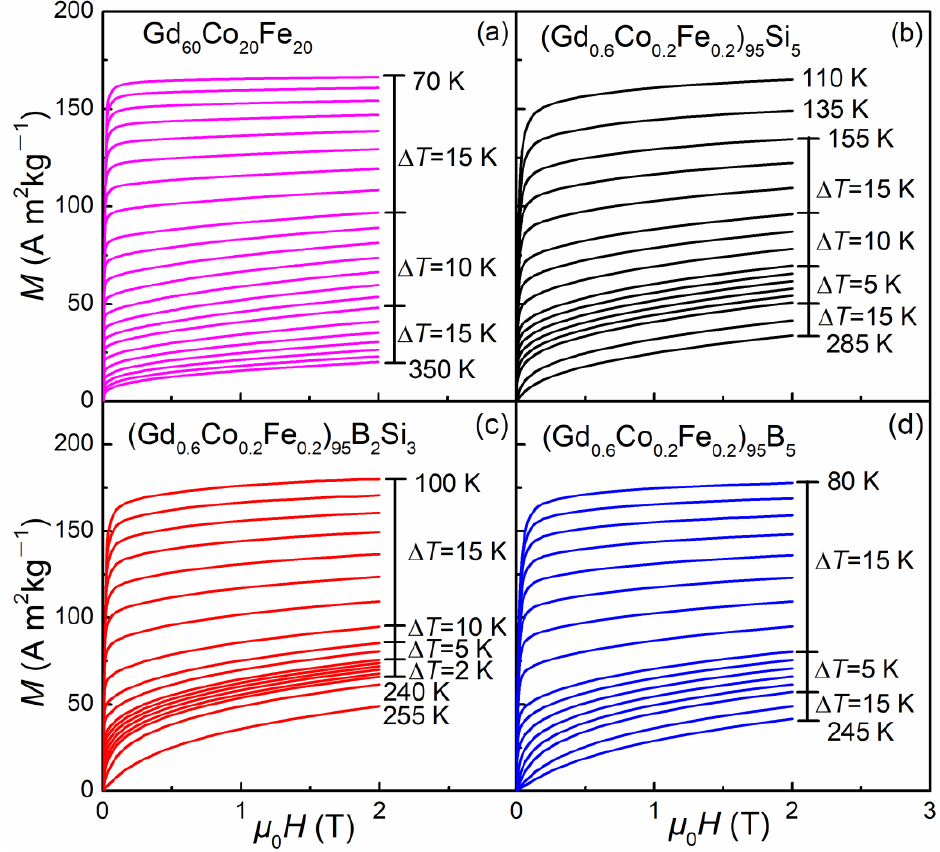
Figure 3. The M – H curves of the ( a ) Gd 60 Co 20 Fe 20 and (Gd 0.6 Co 0.2 Fe 0.2 ) 95 B x Si 5−x amorphous ribbons with x = ( b ) 0, ( c ) 2, and ( d ) 5 at selected temperatures.